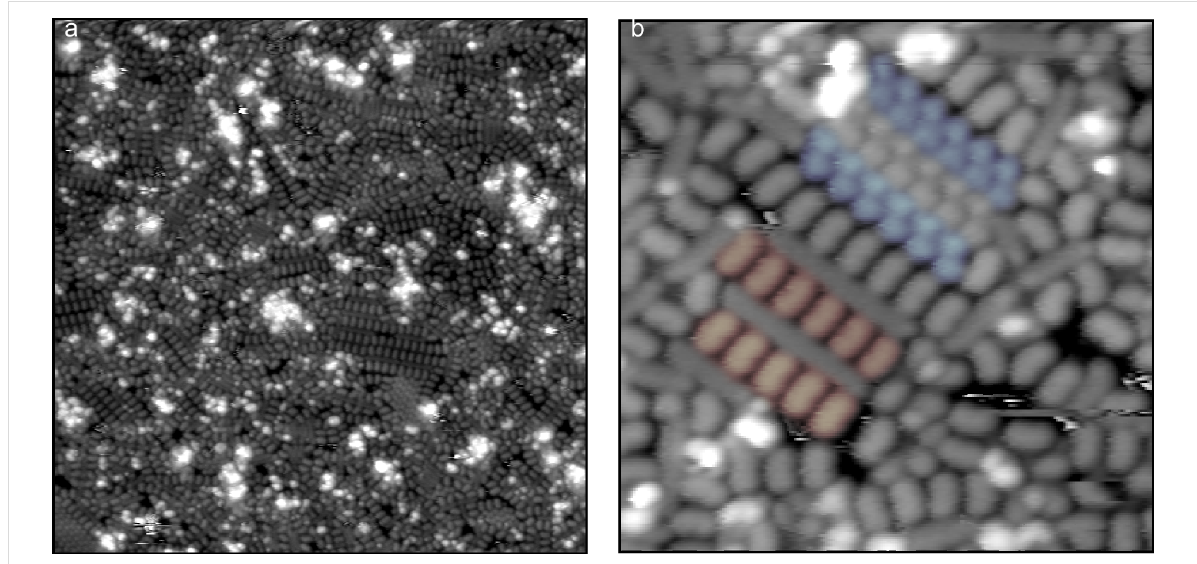
Figure 5: a) A 500 Å × 500 Å STM topography image of 9-fluorenone on Au(111). b) A 110 Å × 109.5 Å STM topography image containing examples of the linear row structures (red), and regions of a close-packed domain (blue).